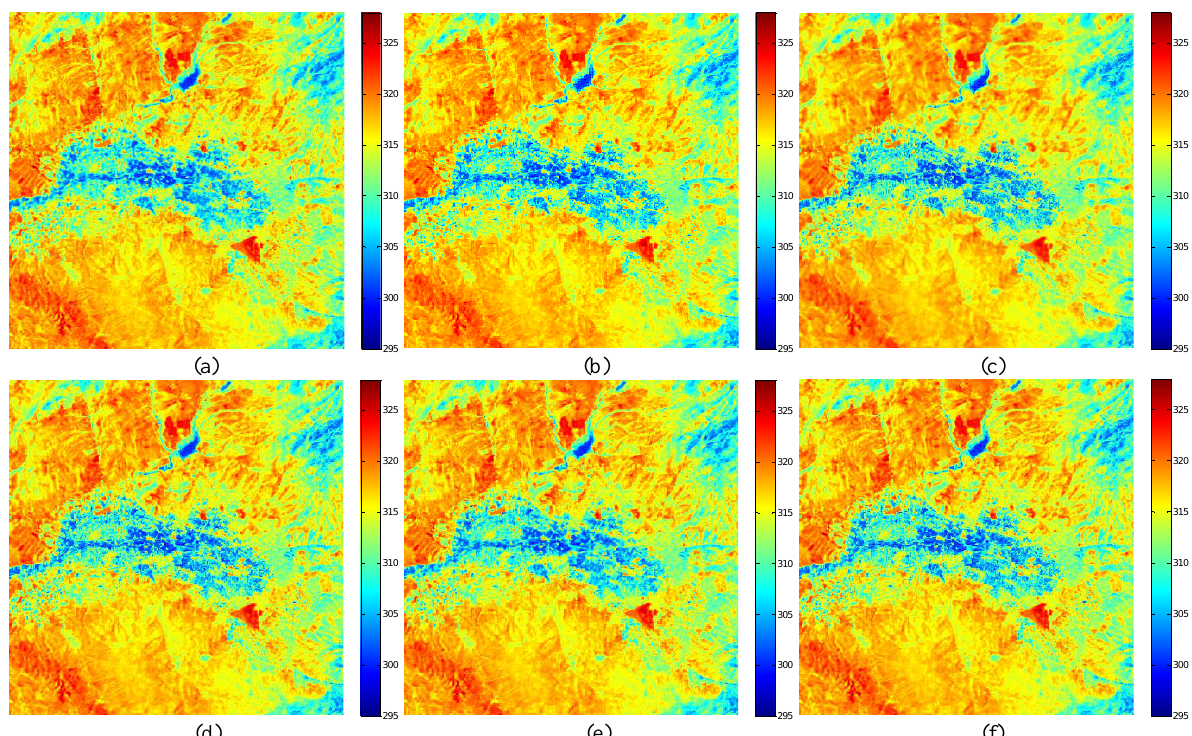
Figure 1. 60 m downscaling results of LST. (a) 60 m reference. (b) TsHARP. (c) RK. (d) DSCK. (e) KED. (f)